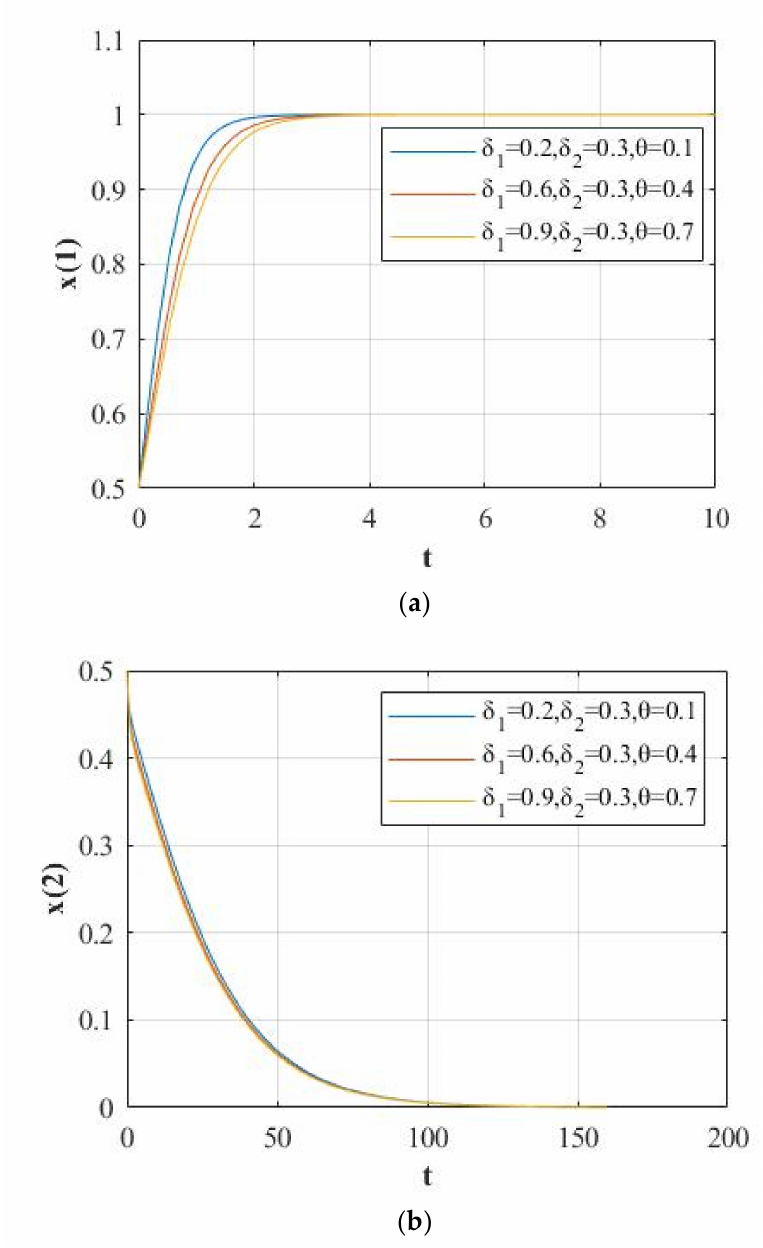
Figure 8. ( a ) While changing δ 1 and θ , and δ 2 = 0.3, evolution diagram of government’s supervision option. ( b ) While changing δ 1 and θ , and δ 2 = 0.3, evolution diagram of platform’s supervision